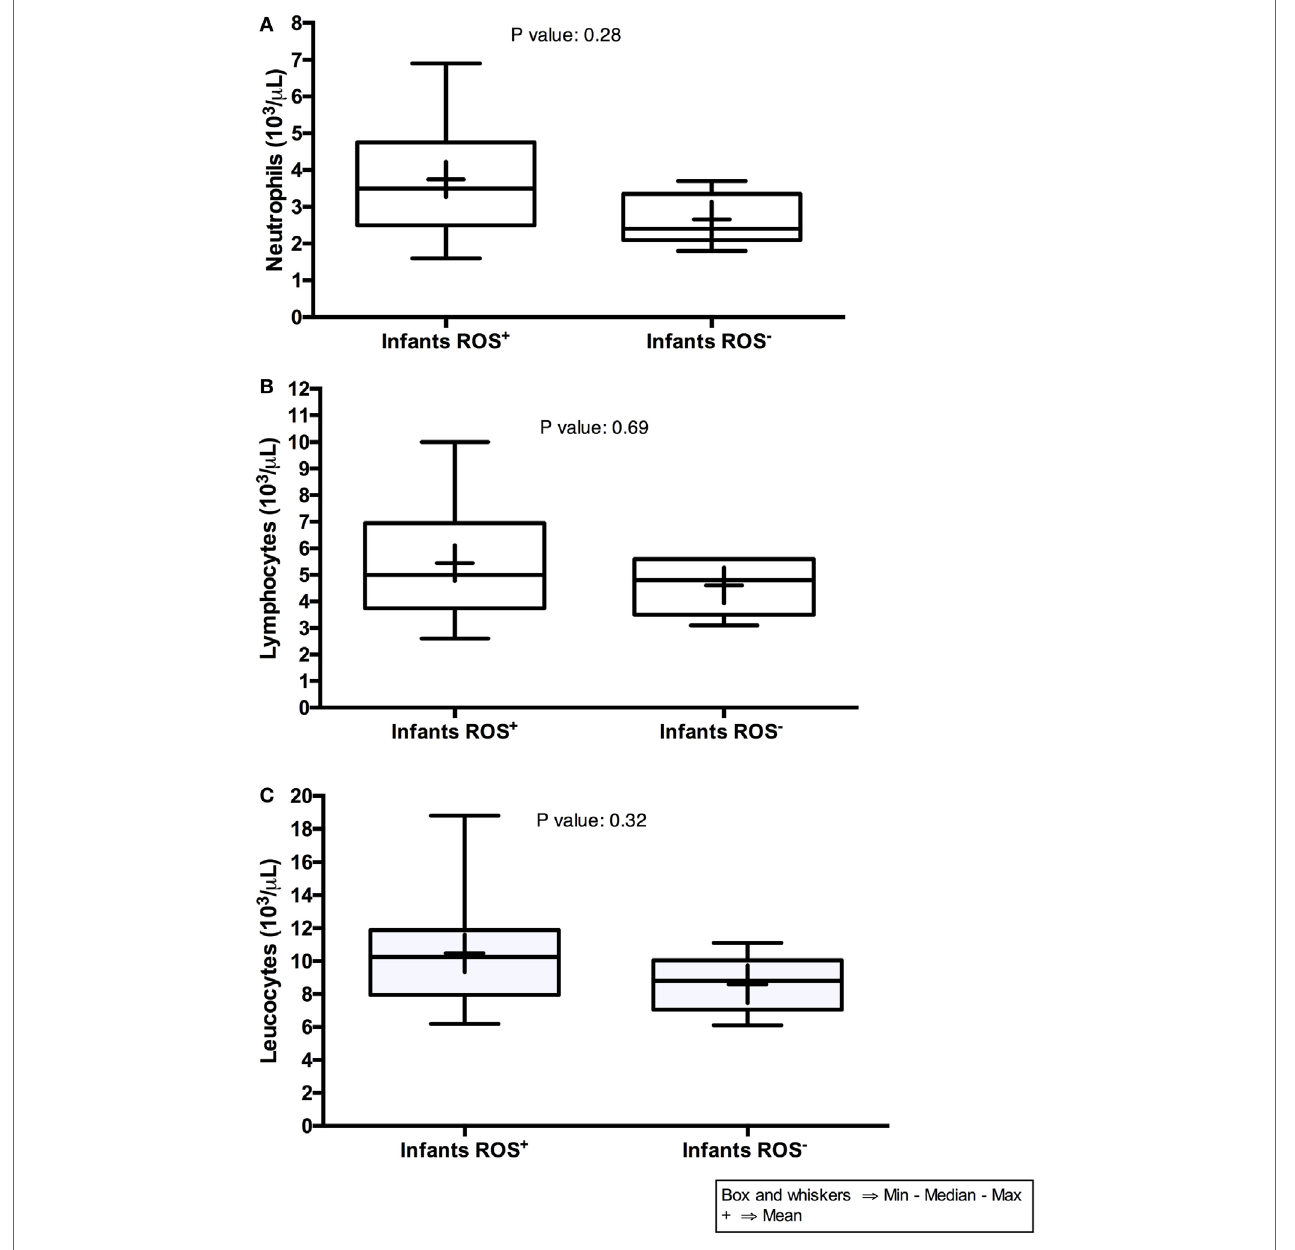
FigUre 3 | neutrophils, lymphocytes, and leukocytes counts of hiV-exposed uninfected infants . On the graphs, Infants ( ROS + ) indicate infants with normal reactive oxygen species (ROS) production, whereas Infants ( ROS − ) indicate infants with impaired ROS